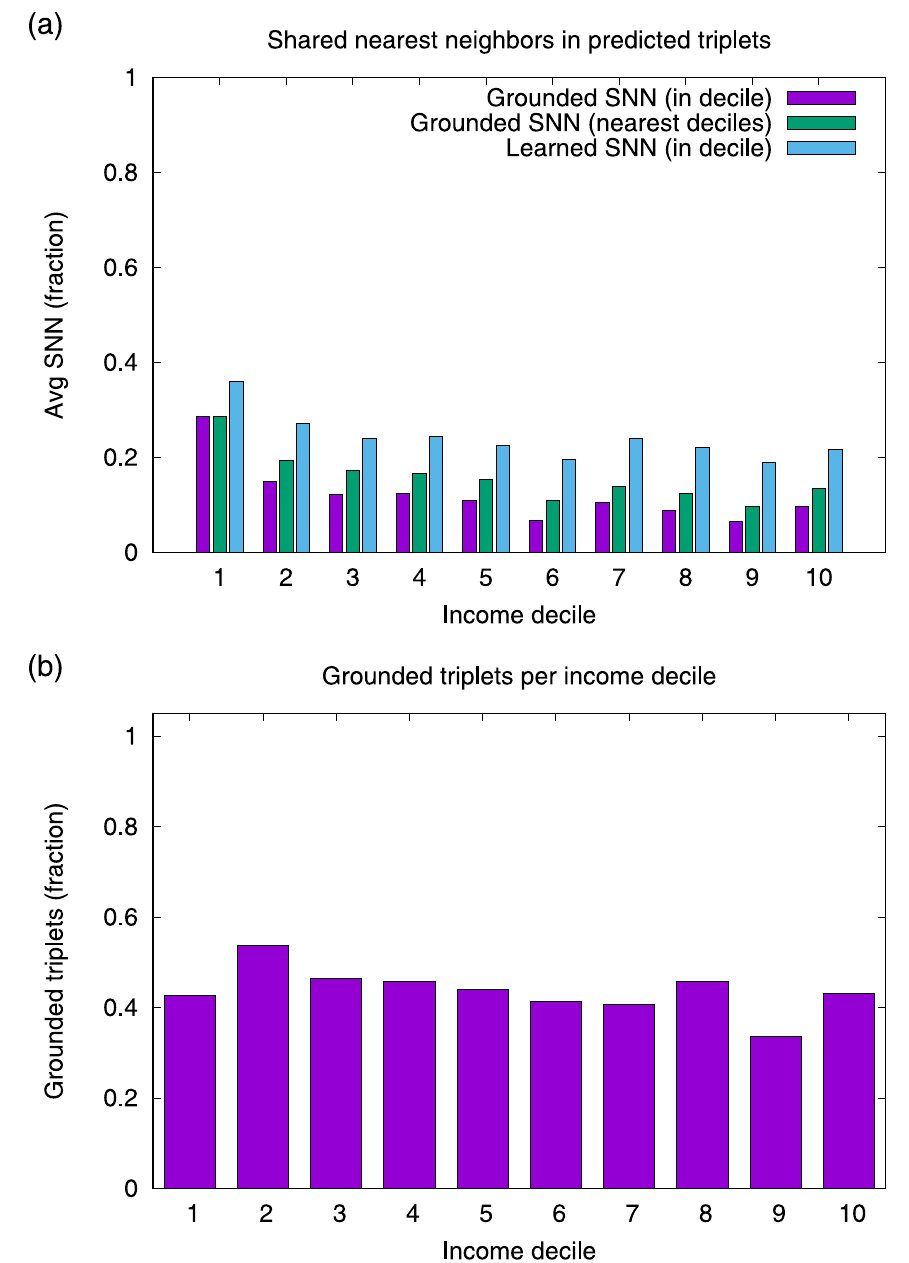
Fig 6. Shared nearest neighbors (SNN) and grounded triplets per income decile. a) The fraction of SNN (average) varies depending on which source of information we consider. The most informative source is proximity-based SNN, although there is significant support based on grounded SNN from the original network. b) Grounded triplets per income decile. The fraction of grounded triplets is always less than half of the predicted triplets, except in decile 2, where it reaches almost 60% of the